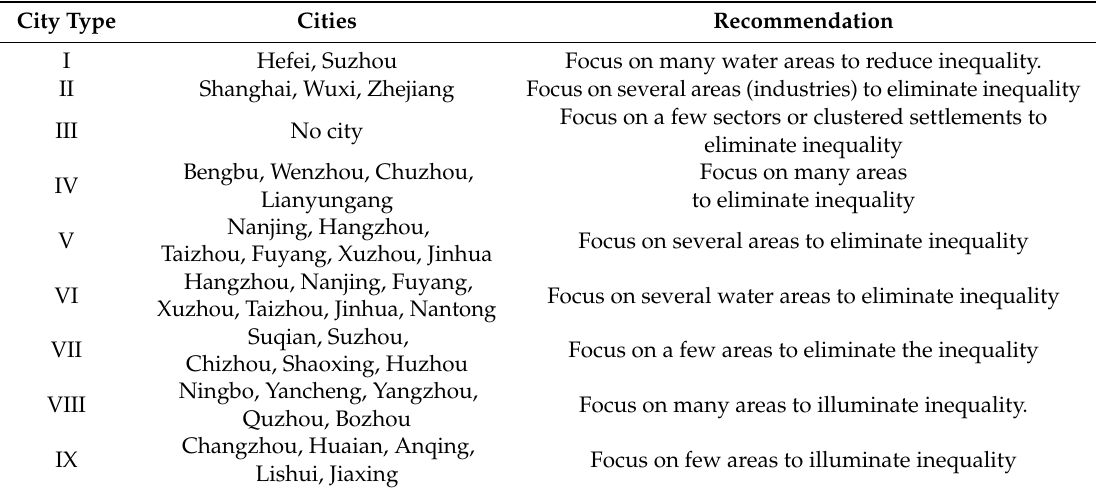
Table 3. Recommendations for various city